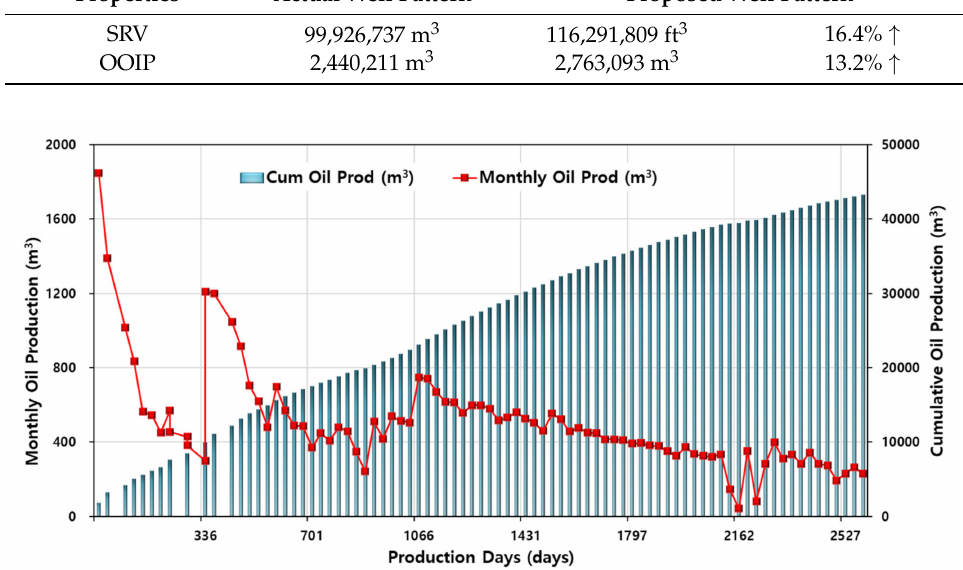
Figure 13. Monthly oil production and cumulative oil production history of SANDY03 well for 7 years (October 2012–September